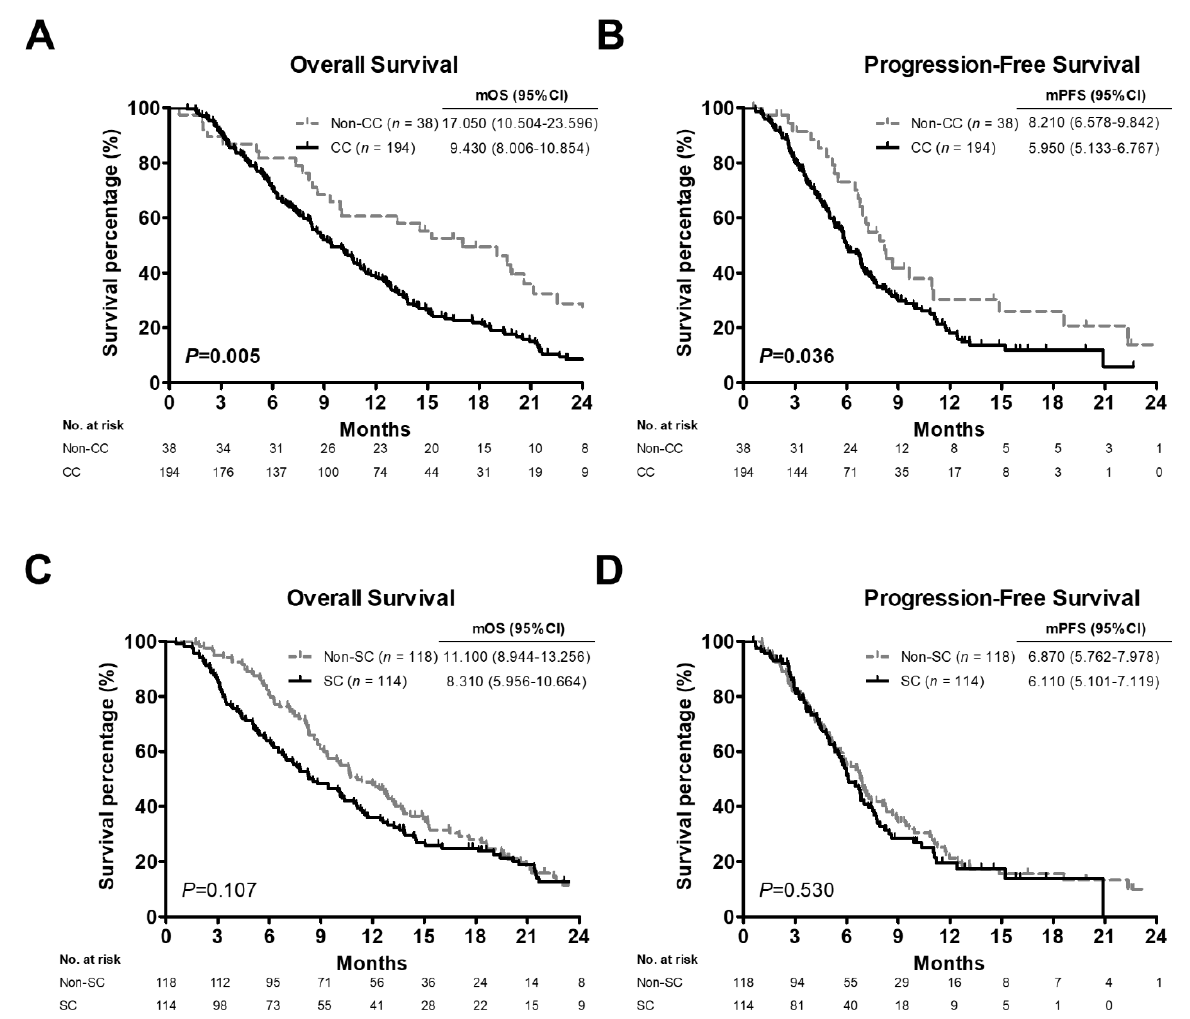
Figure 2. Survival curves of 232 advanced pancreatic cancer patients based on cancer cachexia or sarcopenia status generated by Kaplan-Meier analyses. ( A , C ) Overall survival curves of patients with cancer cachexia ( A ) or sarcopenia ( C ). ( B , D ) Progression-free survival curves of patients with cancer cachexia ( B ) or sarcopenia ( D ). p values determined using the log-rank test. CC, positive cancer cachexia status; Non-CC, negative cancer cachexia status; SC, positive sar- copenia status; Non-SC, negative sarcopenia status; mOS, median overall survival; mPFS, median progression-free survival; CI, confidence